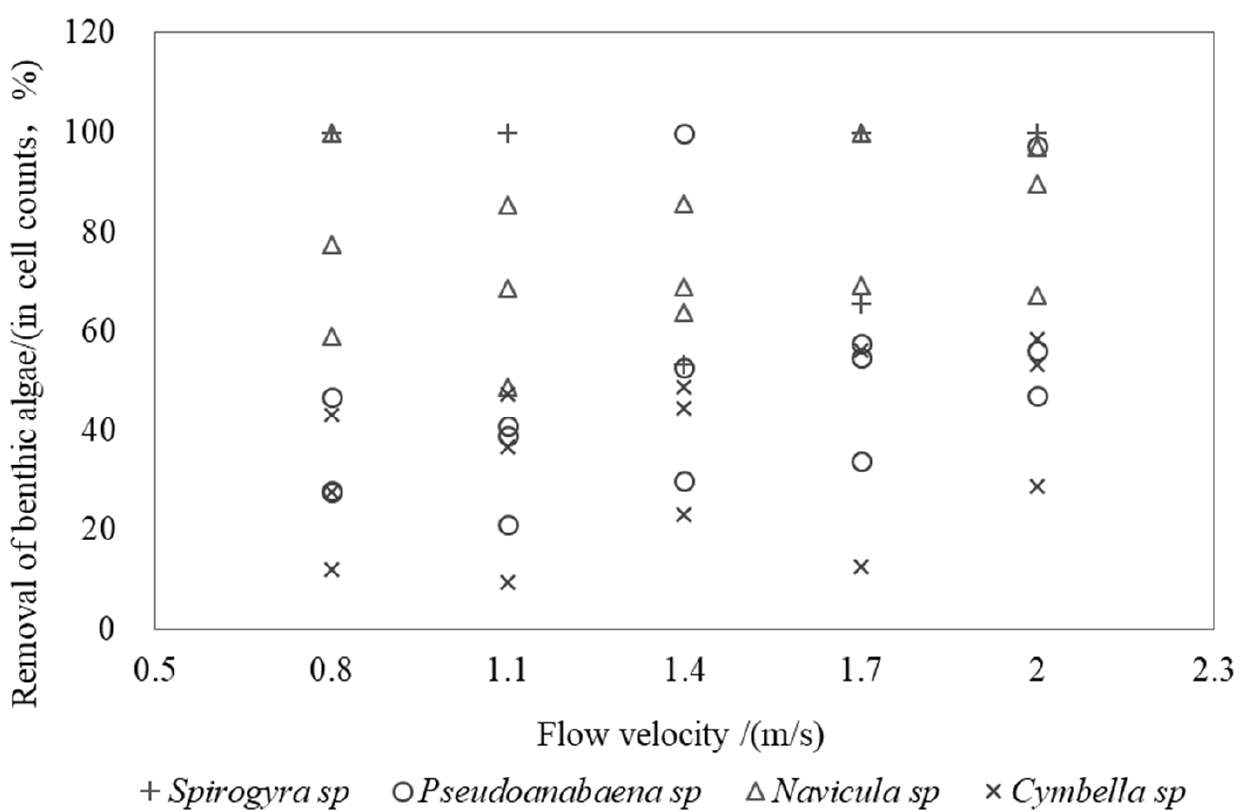
Figure 7. Proportion of removed algae taxa under different flow velocities, 0.8, 1.1, 1.4, 1.7, and 2.0 m/s.